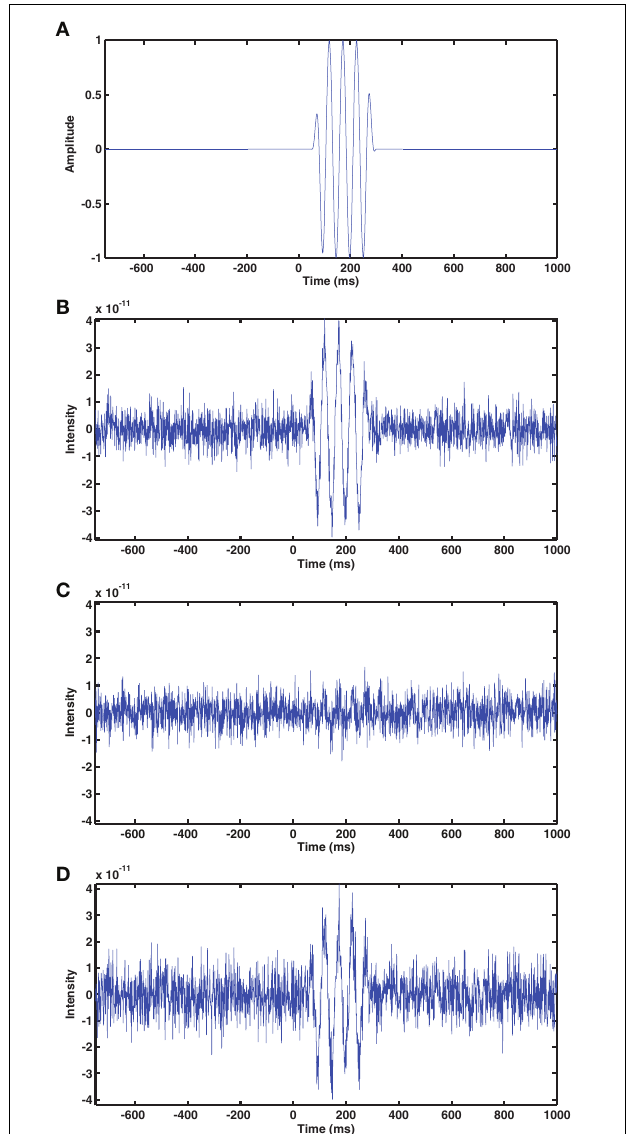
FIGURE 3 | (A) The time series of the simulated source, which was placed at a location in the left hippocampus. Gaussian noise was added to the simulated EEG channels such that the SNR was − 5dB in this example. (B) The beamformer time series at the source location, determined with the EEG coordinates originally used to generate the simulation (measured via fringe projection). (C) The beamformer time series reconstructed using the Fastrak-based electrode coordinates. (D) The beamformer time series reconstructed using the FlyTri-based electrode coordinates. The FlyTri-based reconstruction has a visibly higher SNR than the Fastrak-based reconstruction. error, when using FlyTri or Fastrak electrode coordinates, the resulting output SNR increases to a point with input SNR, but then counterintuitively falls with further increases of input SNR.